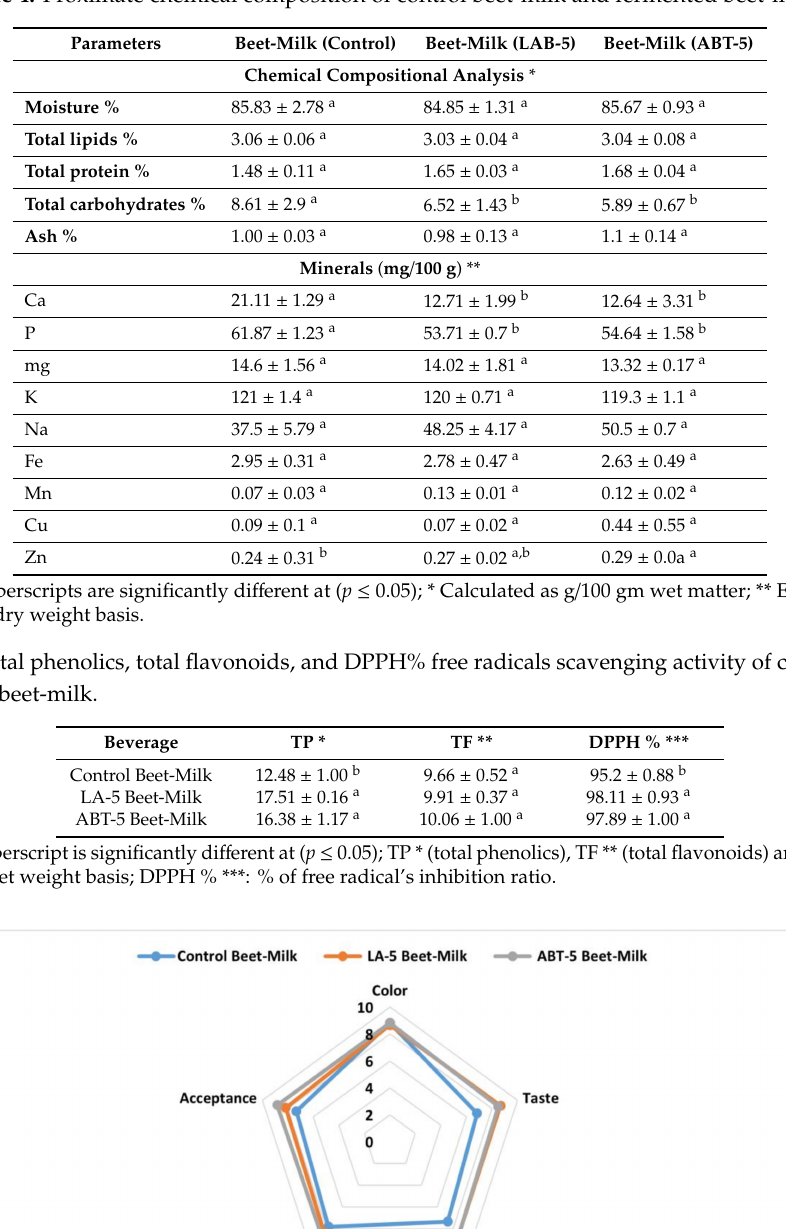
Table 4. Proximate chemical composition of control beet-milk and fermented beet-milk.